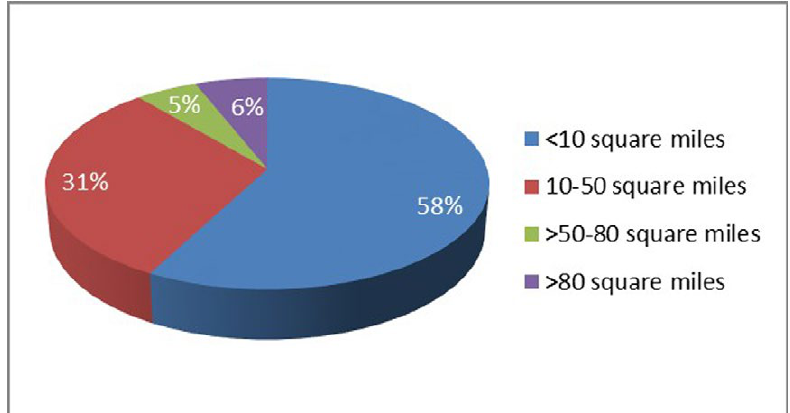
Figure 8: Distribution of watersheds in the sample set by